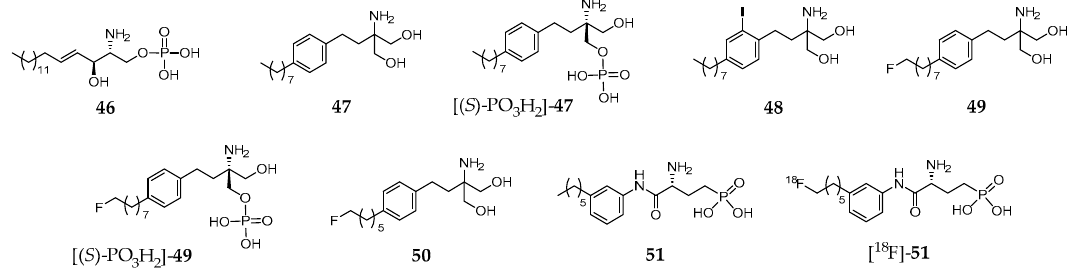
Figure 6. Sphingosine 1-phosphate (S1PR) ( 46 ) and derivatives.